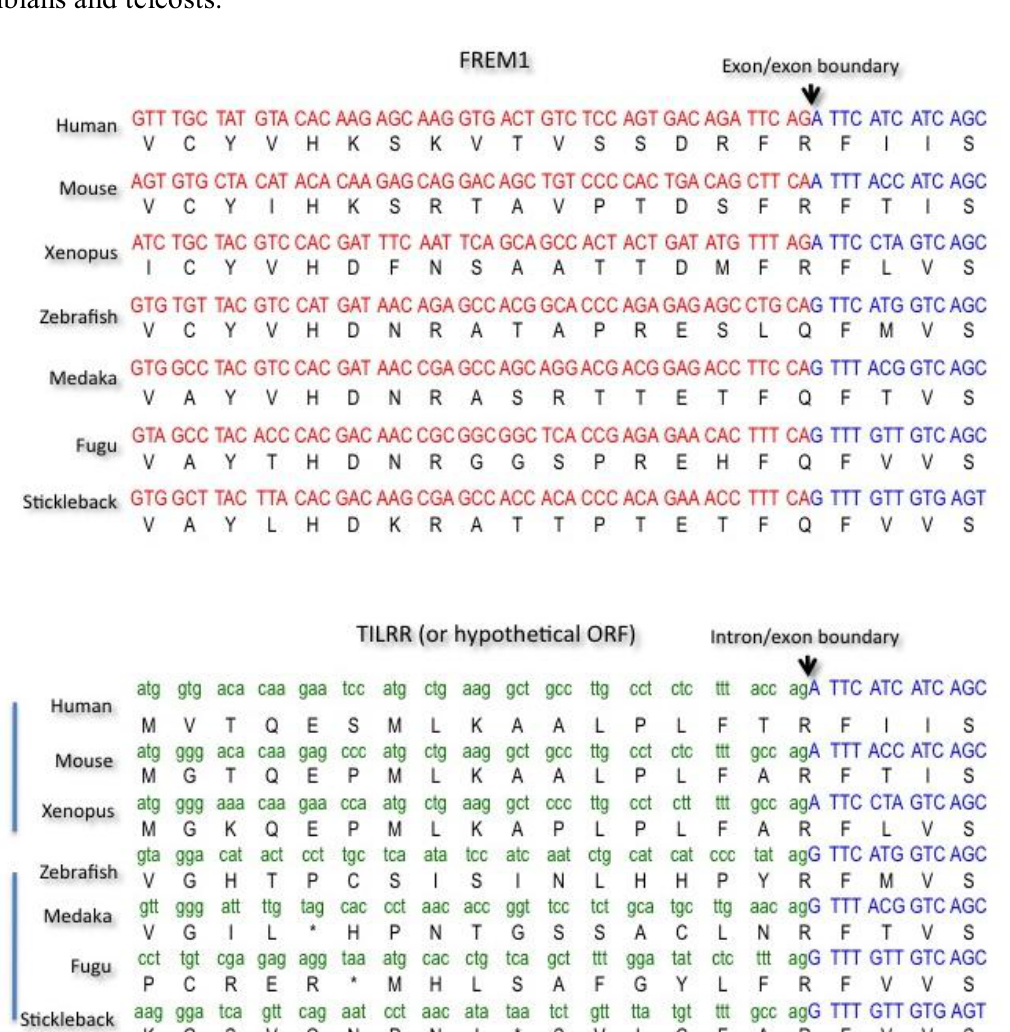
Figure 5. Comparative alignment of coding sequence of FREM1 and TILRR in mammals, amphibians and